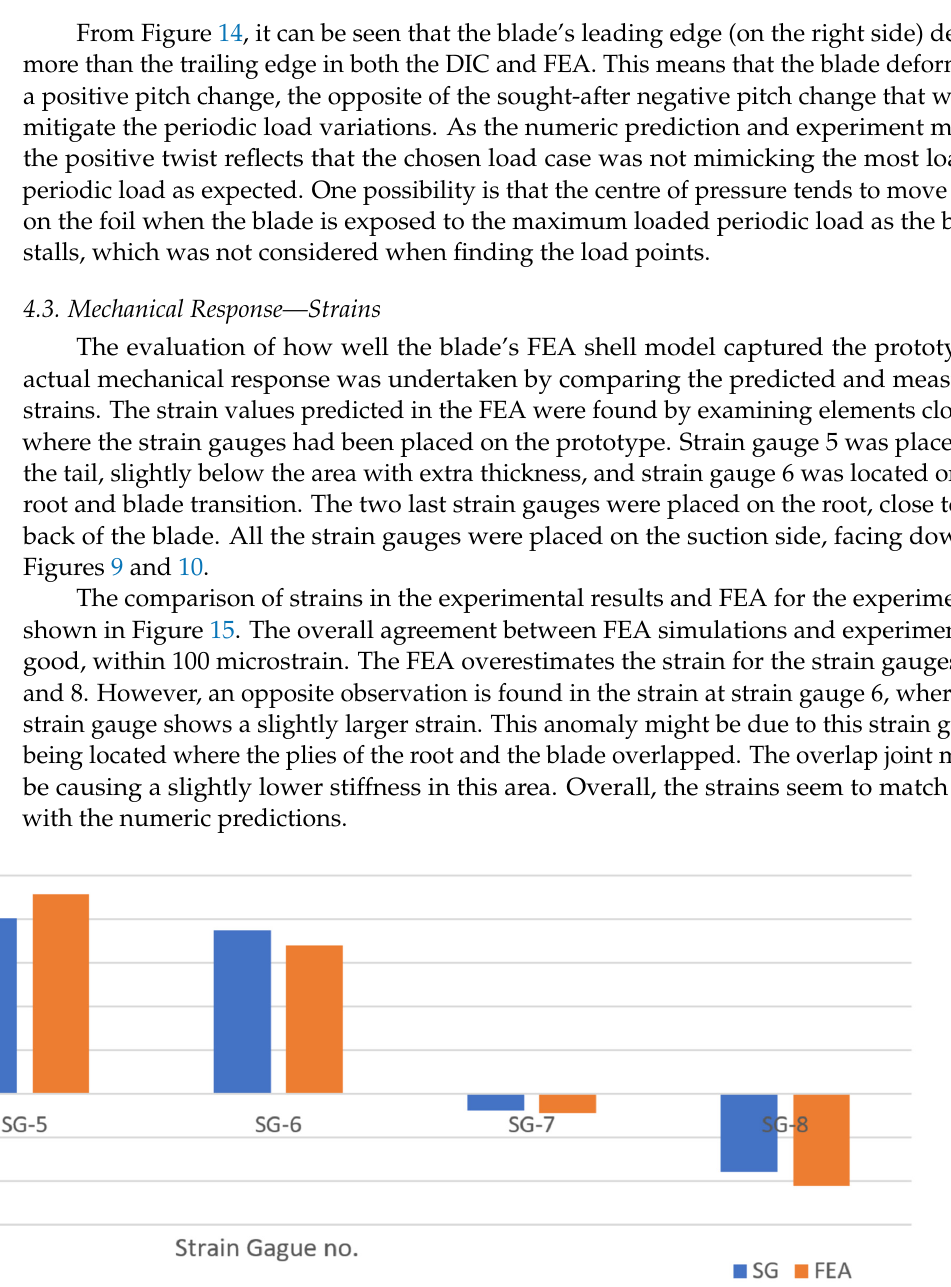
Figure 15. Comparison between strain gauge data and predictions in the FEA. It is seen that the FEA overestimates the strain in general but underestimates the strain at strain gauge 6, located at a ply overlapping joint.